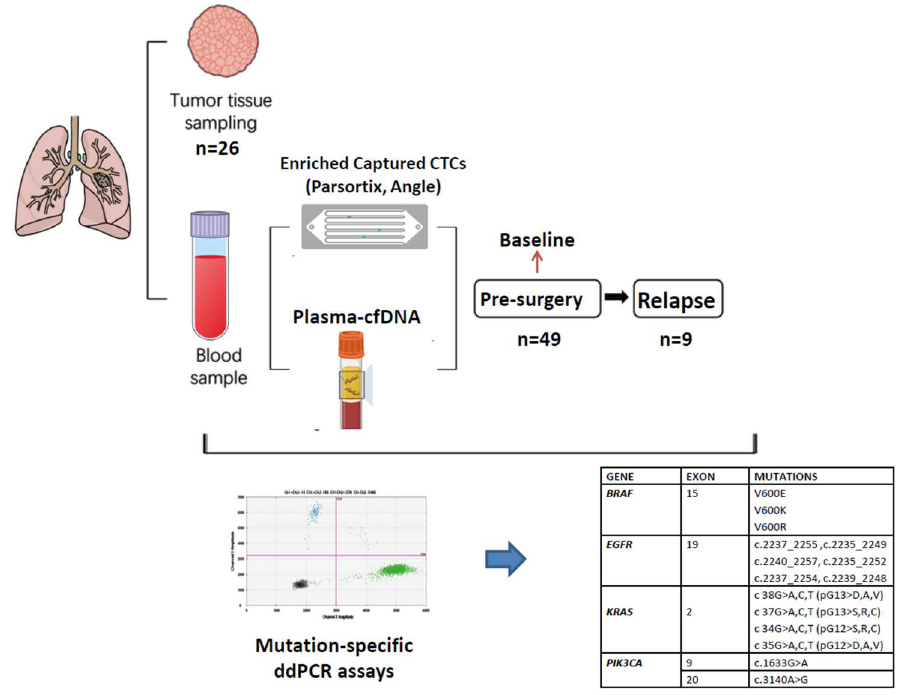
Figure 1. Outline of the experimental